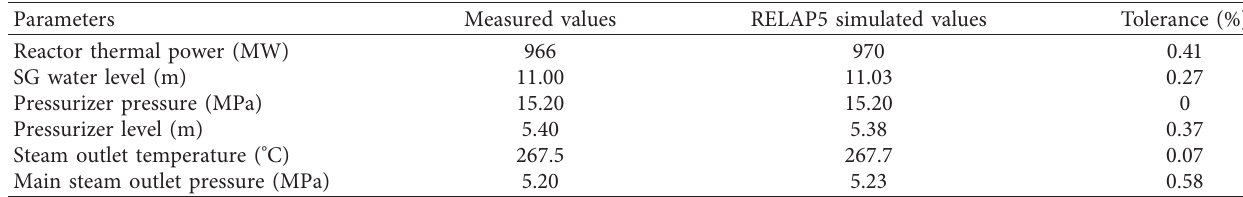
Figure 1: Qinshan I RCS nodalization diagram. Table 1: Table of simulation